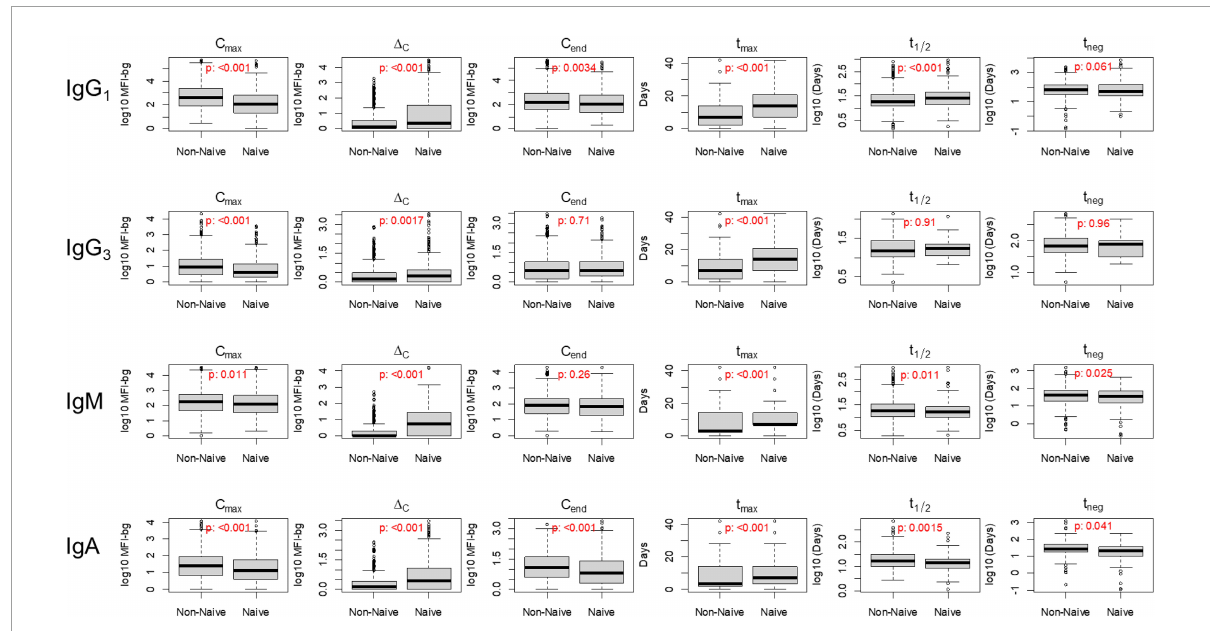
FIGURE3 Distribution of six key post-treatment clearance parameters in non-naïve and naïve Angolan children treated for malaria, stratifying by immunoglobulin (Ig) class/subclass. P -value for Kolmogorov–Smirnov test for difference in empiric distribution between non-naïve and naïve participants. Mean values between non-naïve and naïve categories are displayed in Table 2 .